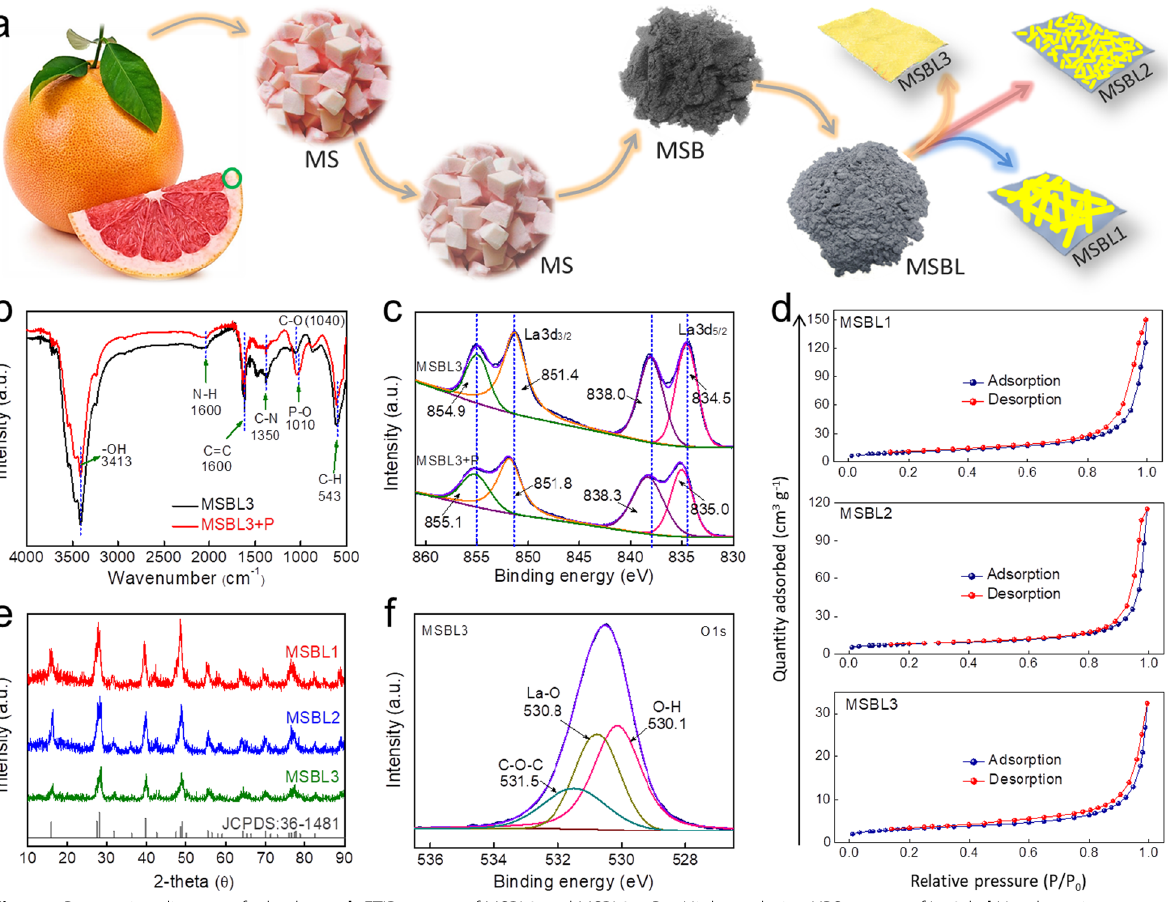
Fig. 1 a Preparation diagram of adsorbents; b FTIR spectra of MSBL3 and MSBL3 desorption curve of adsorbents; e XRD pattern of adsorbents; f High-resolution XPS spectra of